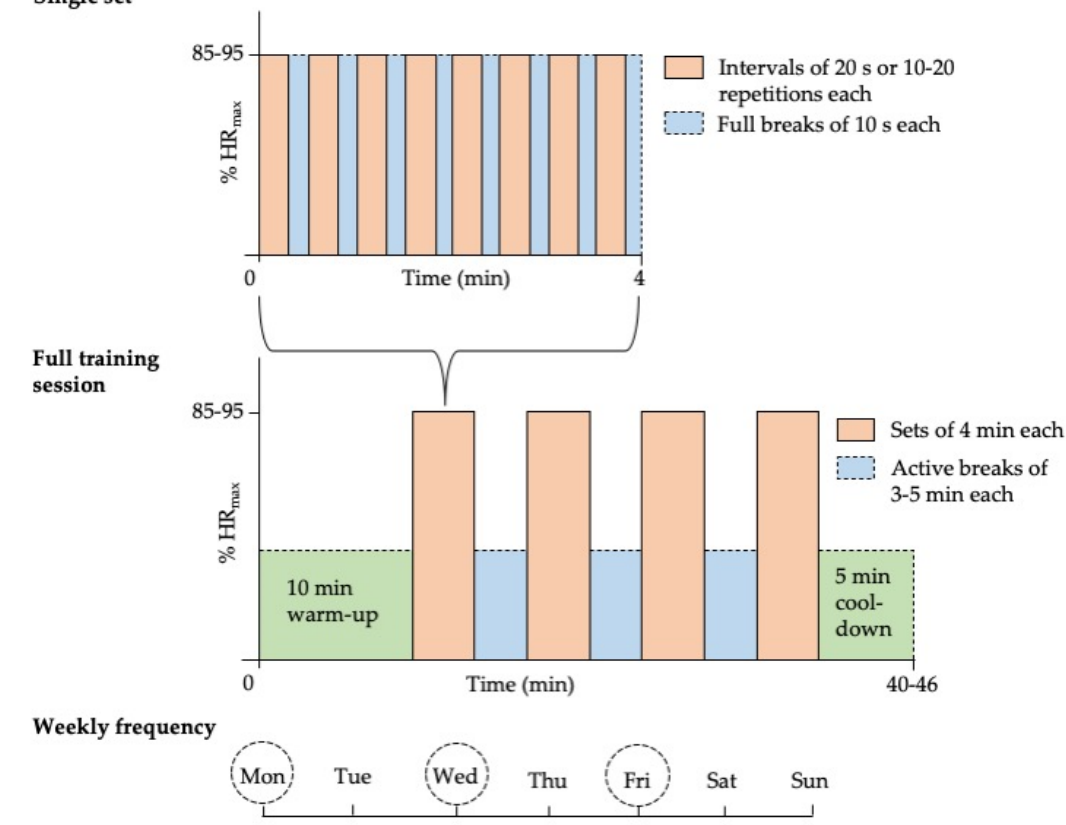
Figure 1. Evidence-based exercise recommendations. Intermittent high-intensity interval training (I-